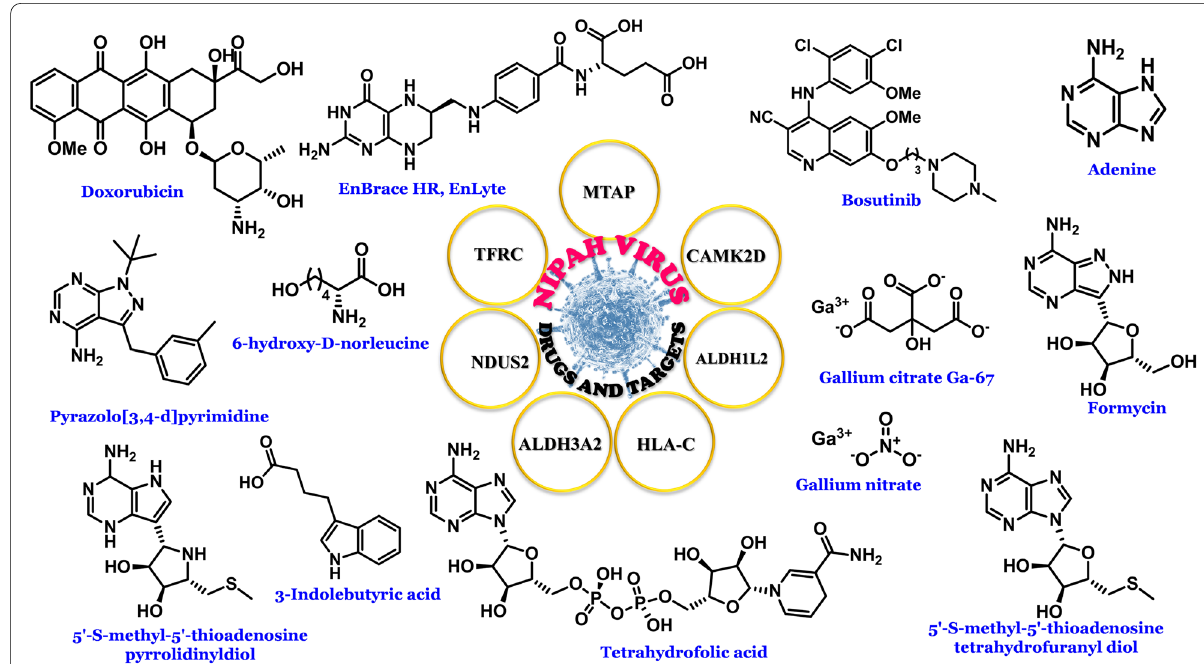
Fig. 5 Illustrative representation of some active targets and drugs against nipah virus are as follows: a Targets are MTAP, CAMK2D, ALDH1L2, HLA-C, ALDH3A2, NDUS2, TFRC; b Drugs are as Doxorubicin, EnBrace HR (EnLyte), Bosutinib, Adenine, Pyrazolo[3,4-d]pyrimidine, 6-hydroxy-D-norleucine, Gallium citrate Ga-67, Formycin, 5’-S-methyl-5’-thioadenosine pyrrolidinyldiol, 3-Indolebutyric acid, Tetrahydrofolic acid, Gallium nitrate, 5’-S-methyl-5’-thioadenosine tetrahydrofuranyl